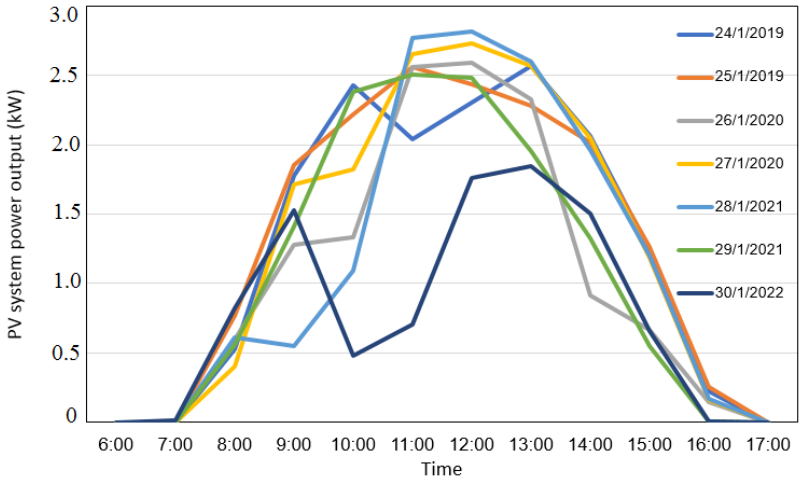
Figure 5. An example for a single household PV system output (House 7) over one week with unclear (cloudy) weather.